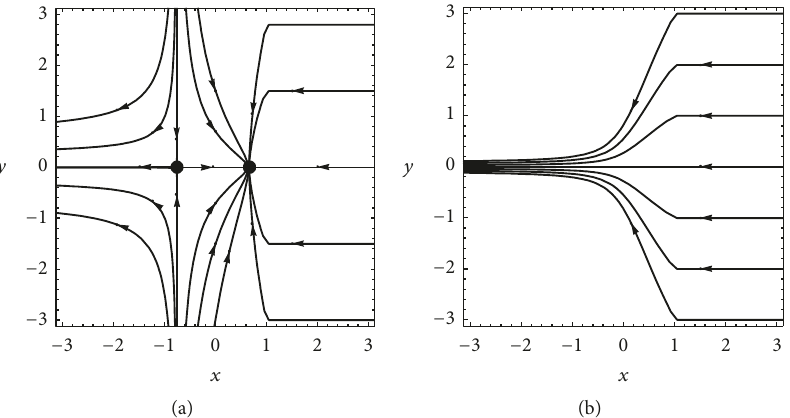
Figure 8: From left to right phase portraits corresponding to the open regions I and II in Figure 7,